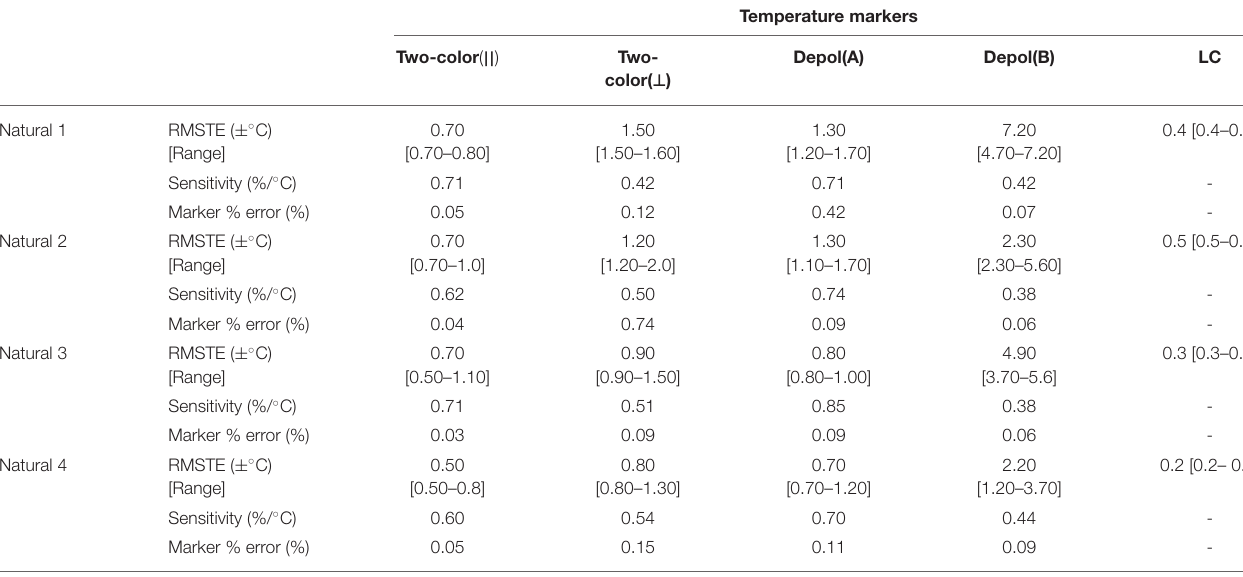
TABLE 3 | RMSTEs ( ± ◦ C), sensitivities (% change/ ◦ C), and absolute percentage errors in markers (%) for natural water sample analyzed by two-color and depolarisation